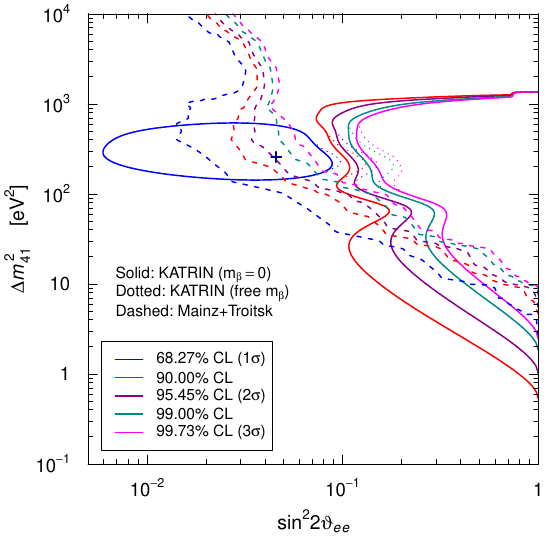
Figure 1 . Con(cid:12)dence level contours in the (sin 2 2 # ee ; (cid:1) m 2 KATRIN data with m (cid:12) = 0 (solid) and free m (cid:12) (dotted), and from the results of the Mainz [5] and Troitsk [6, 7] experiments [8]. The blue cross indicates the KATRIN best-(cid:12)t